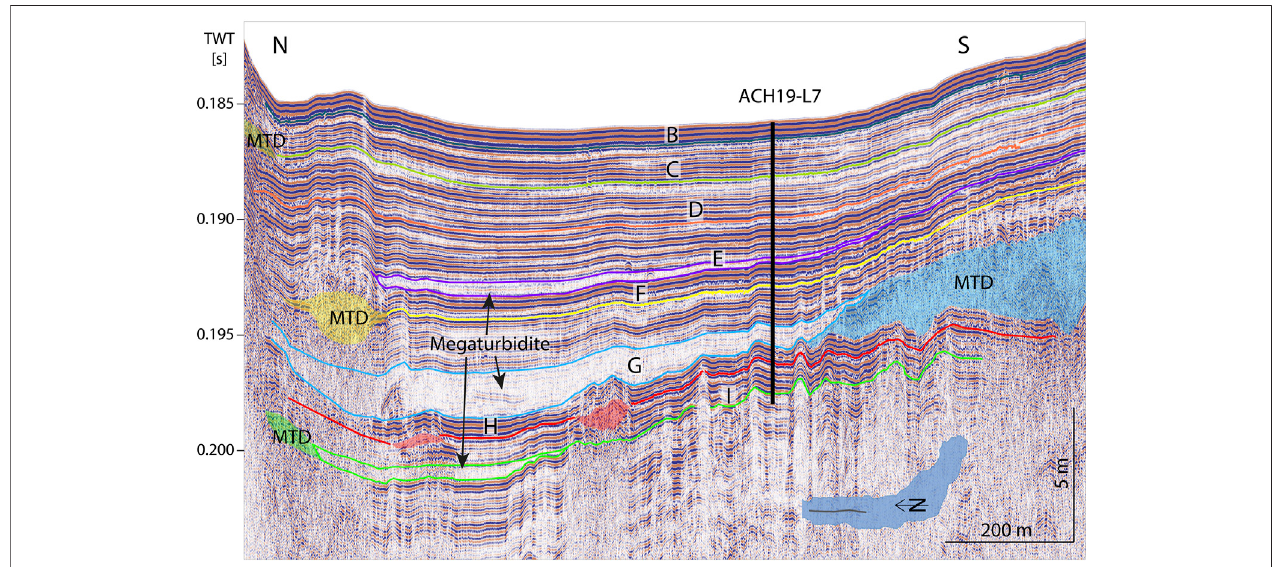
FIGURE7 | Pinger pro fi le along the Main basin (zoom of Figure 3 ).The Main basin contains acomplete record ofevent horizons (B – I) withmultiple MTDs. In event horizons G and I, MTDs are directly overlain by megaturbidites indicating their cogenetic formation. Vertical black line displays projected depth of core ACH19-L7 ( Figure 9 ). Map inset indicates location of seismic pro fi